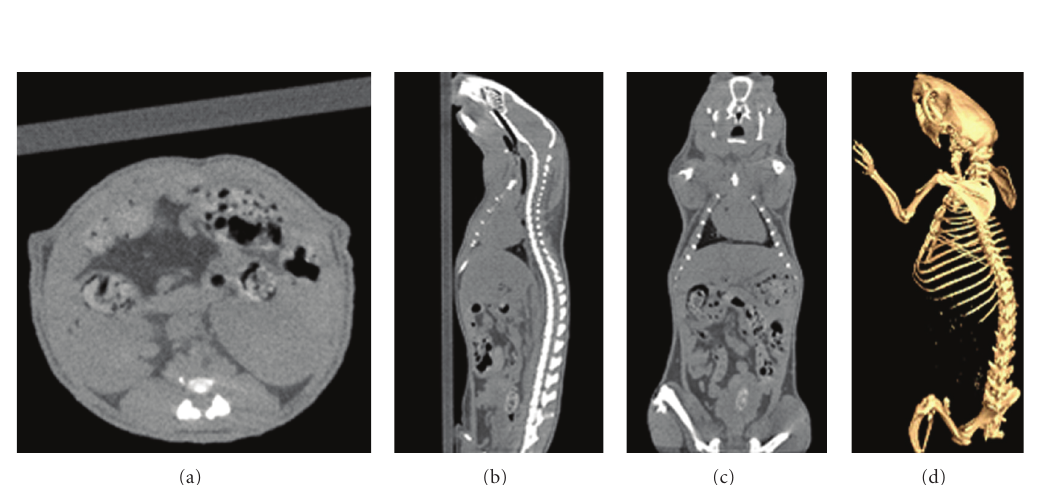
Figure 11: 3D reconstruction results of a mouse: (a) transaxial view, (b) sagittal view, (c) coronal view, and (d) bone structure.